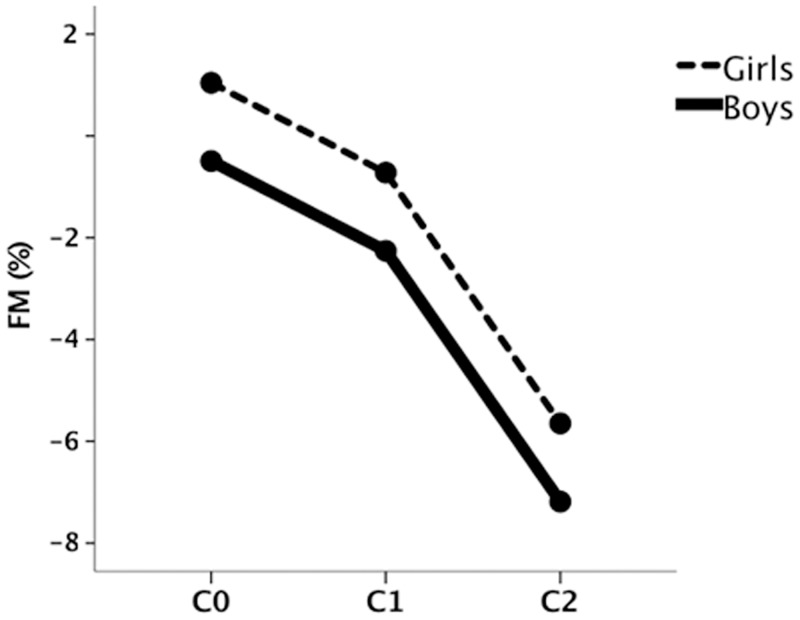
Changes in fat mass percentage after a 2-year follow-up across change in maturation status (C0, change from on time to late; C1, no change; C2, change from late/on time to on time/early) by sex.p = 0.081 and p = 0.080, for pairwise comparisons between C0-C2 and C1-C2 respectively from general lineal model analysis. p>0.05, for maturation status x sex interaction from general lineal model analysis.